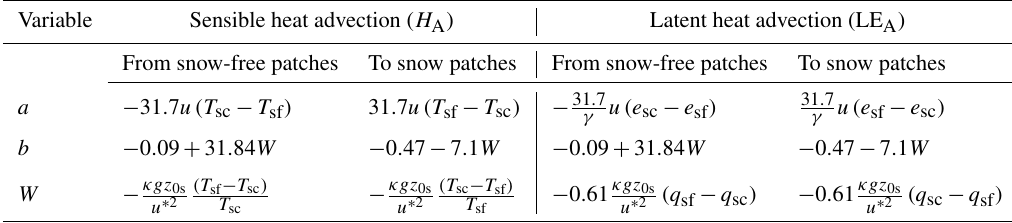
Table 1. Parameterizations for extended GM2002. Variable